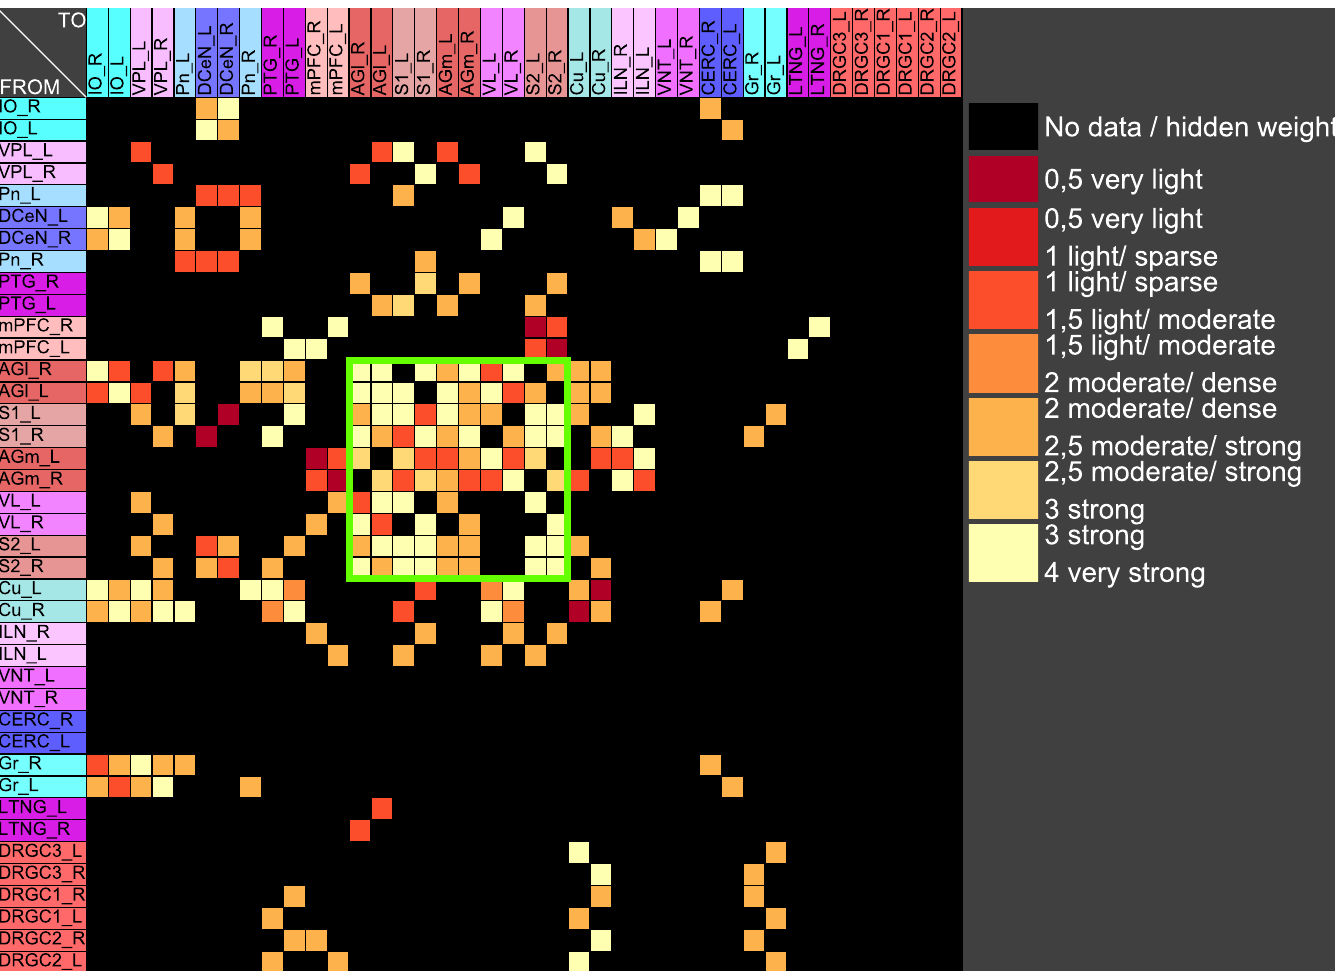
Fig 9. Spectral cluster analysis of the average cross-correlation matrix of the variation of four parameters of the MM model. The average cross-correlation of the variation of the four reaction parameters has been analyzed by spectral clustering. A similar group of regions (green rectangle) could be determined as found with the GM parameter